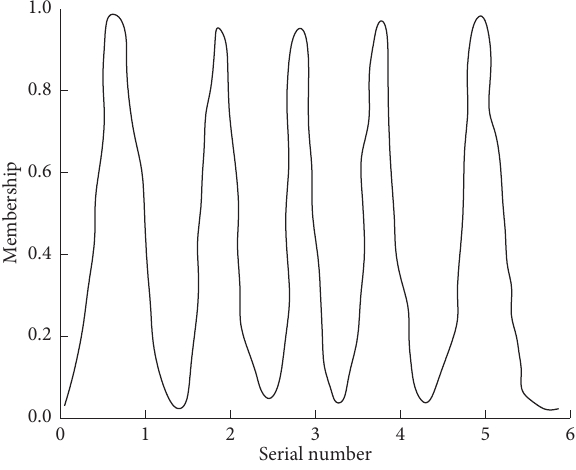
Figure 8: Membership relation.